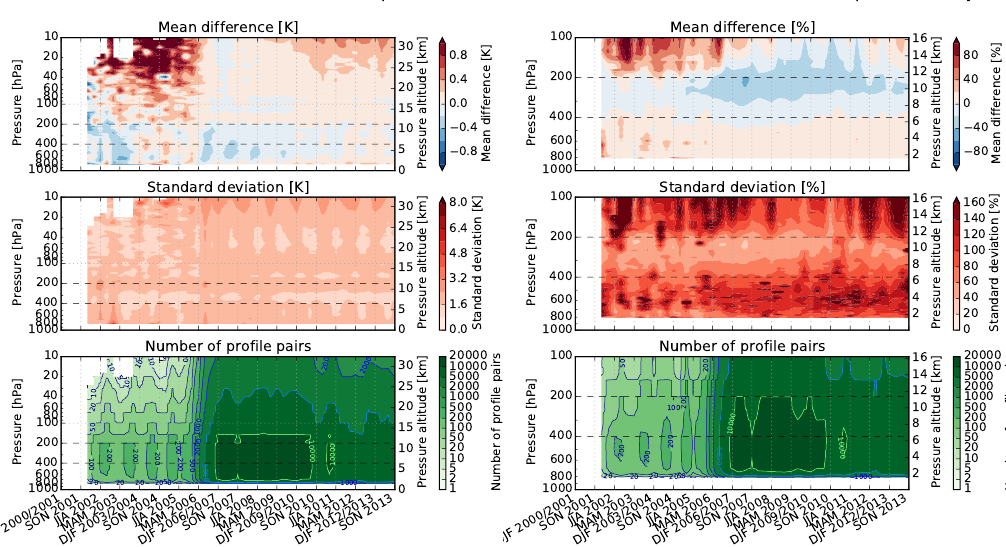
Figure 3. DJF 2001/02 to SON 2013 global-mean seasonal differences for temperature (left) and specific humidity (right) between WEGC GPSRO data and Vaisala RS 90/92 data (top), the related standard deviations (middle), and the associated number of collocations